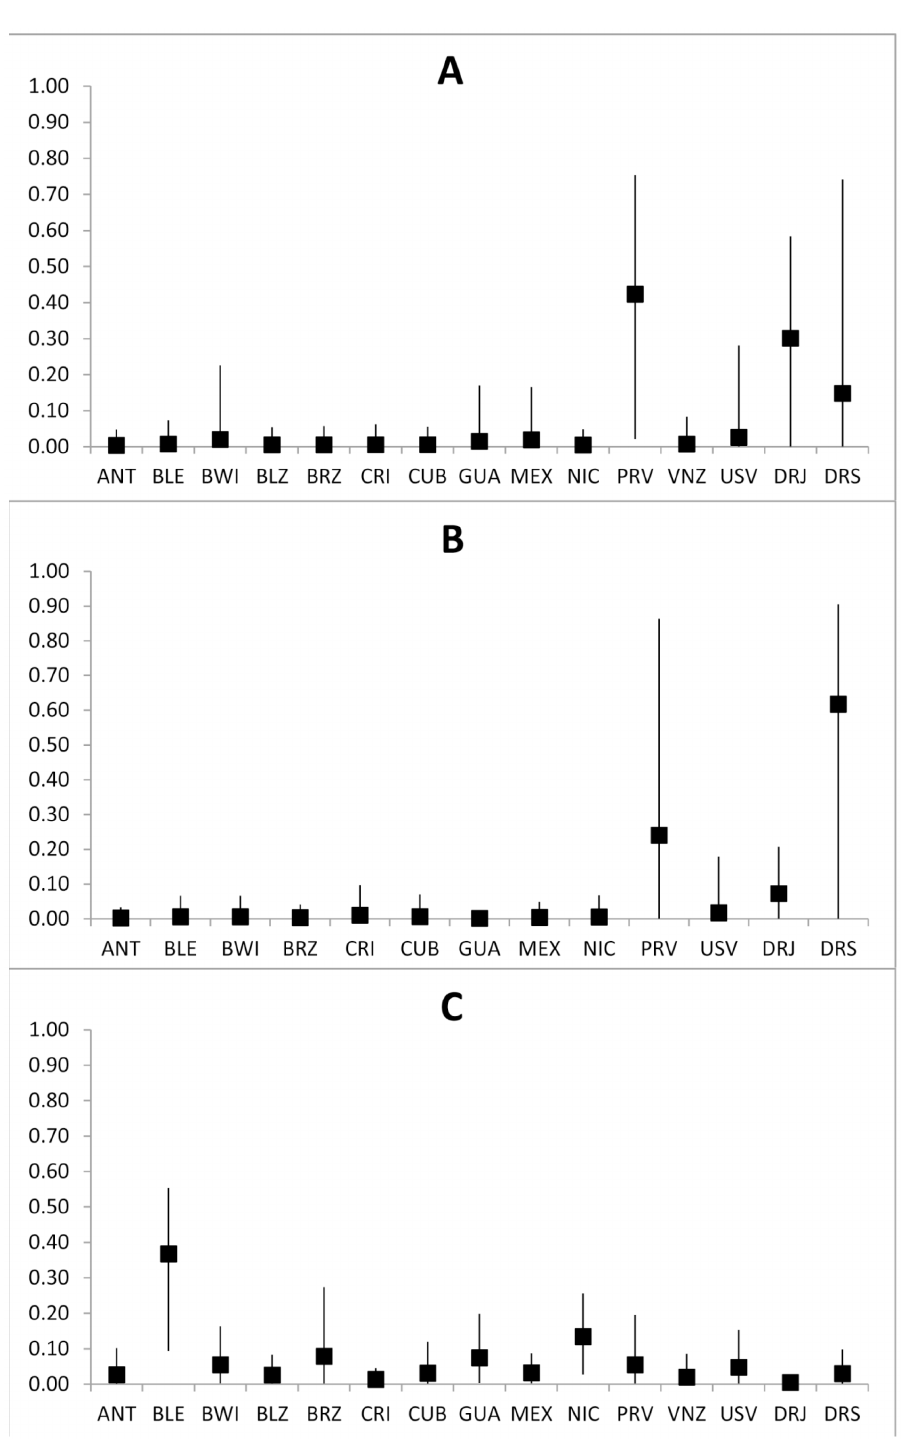
Figure 3. Mixed Stock analysis. Relative contribution and 95% confidence interval of each hawksbill turtle nesting area to the male aggregation of Mona Island (Puerto Rico) using A) the short (380 bp ) mtDNA fragment, B) the long (720 bp ) mtDNA fragment and C) to the SW Dominican Republic feeding ground using the short (380 bp ) mtDNA fragment. ANT: Antigua; BLE: Barbados Leeward; BWI: Barbados Windward; BLZ: Belize; BRZ: Brazil; CRI: Costa Rica; CUB: Cuba; GUA: Guadeloupe; MEX: Mexico; NIC: Nicaragua; PRV: Puerto Rico [35]; PRB: Puerto Rico [64]; USV: US Virgin Islands; VNZ: Venezuela; DRJ: Dominican Republic-Jaragua; DRS: Dominican Republic-Saona.